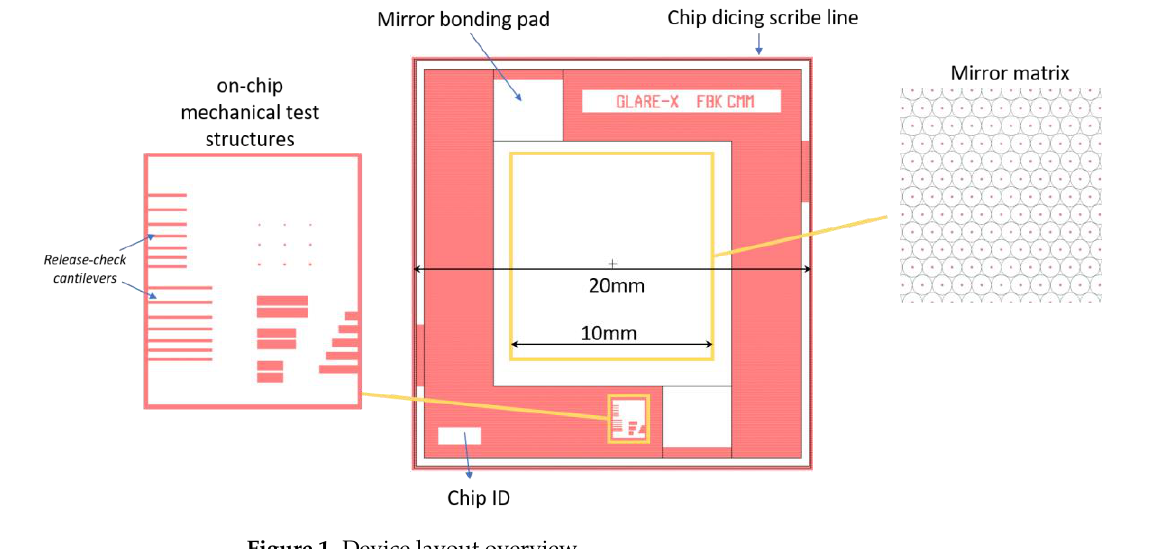
Figure 1. Device layout overview.